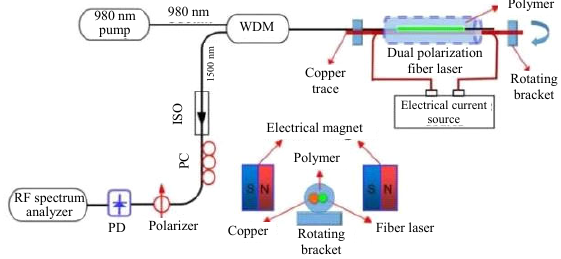
Fig. 3 Measured response of the sensor to different AC frequencies in a magnetic field of 3 kGs and at a constant peak-to-peak AC current level of 1 A.